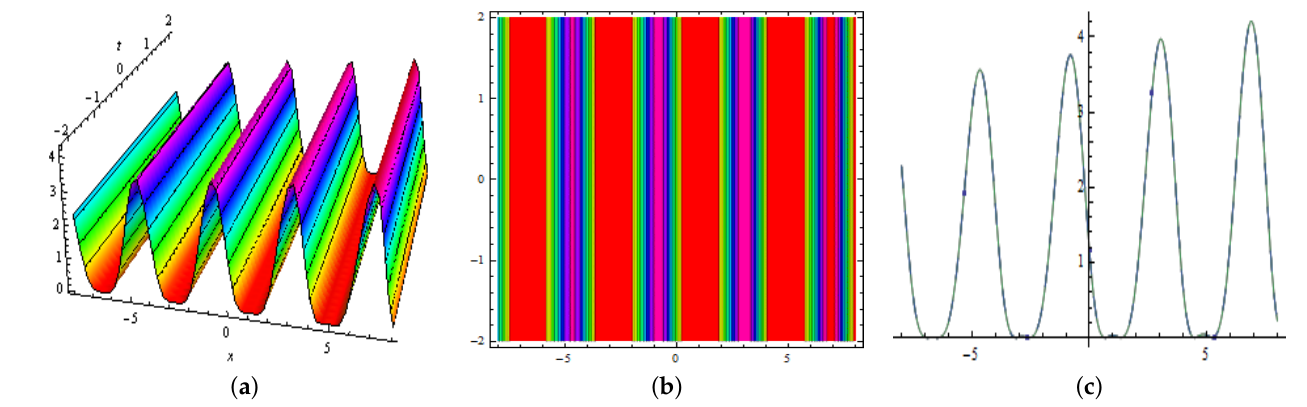
Figure 11. represented three-dimensions in ( a ); contour in ( b ) and two-dimensions in ( c ), Plots of n 4 ( x , t ) in Equation (43) at a = 2, u 0 = − 1, b 3 = 0.1, b 4 = − 3, b 5 = 7, b 6 = 3, b 7 = 2, α = 0.5,